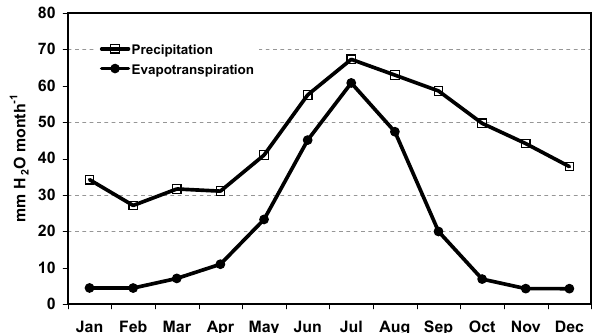
Fig. 14. Seasonal variations of the average evapotranspiration and precipitation over the entire Canadian landmass for